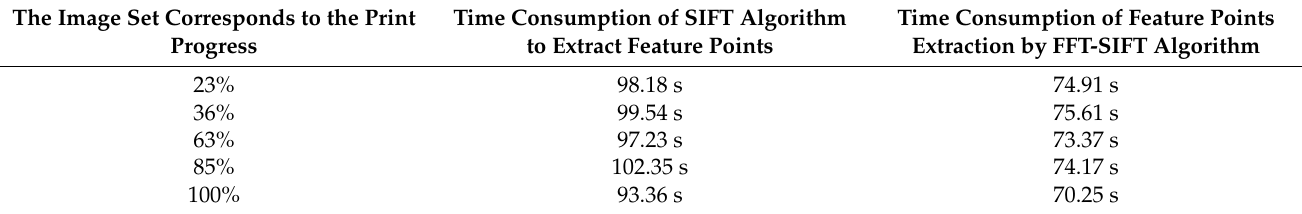
Table 2. Comparison of feature extraction time of different algorithms in the printing process. The Image Set Corresponds to the Print Time Consumption of SIFT Progress